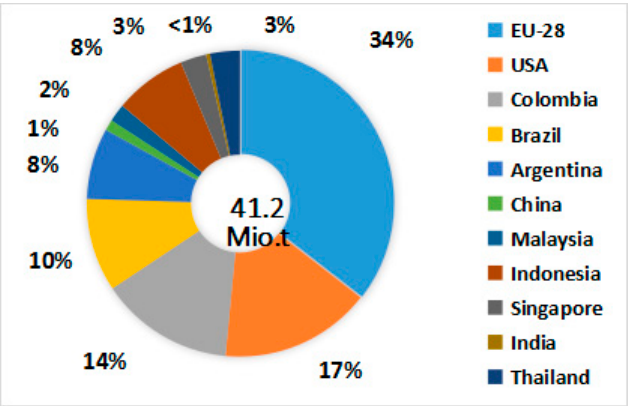
Figure 1. Biodiesel production contribution by different countries for the year 2018 .